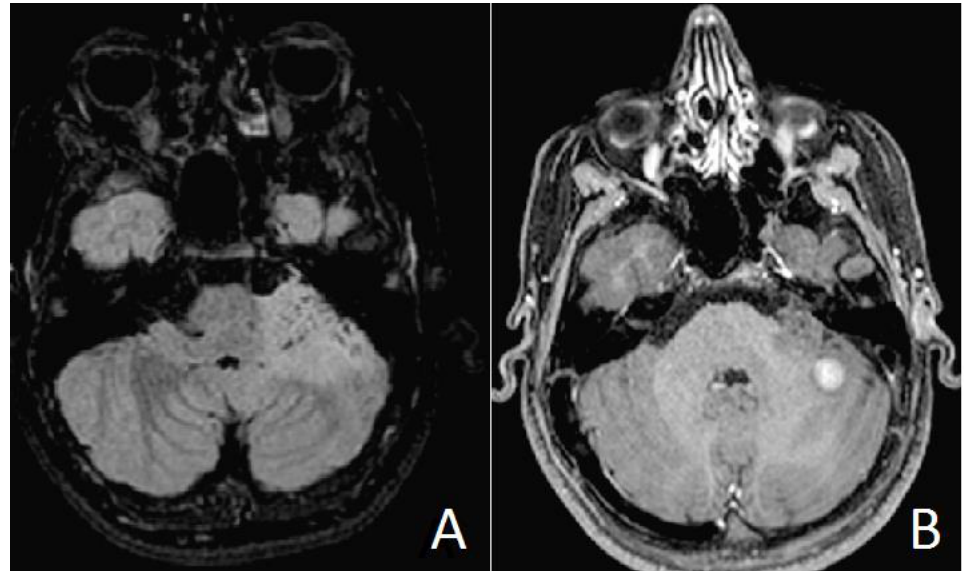
Figure 1. Preoperative brain MR images. Axial FLAIR T2 weighted images ( A ) showing microcystic areas inside the left hemispheric cerebellar lesion, infiltrating the middle cerebellar peduncle. Axial gadolinium-enhanced T1 weighted images ( B ) exhibiting a solid central enhanced nodule.